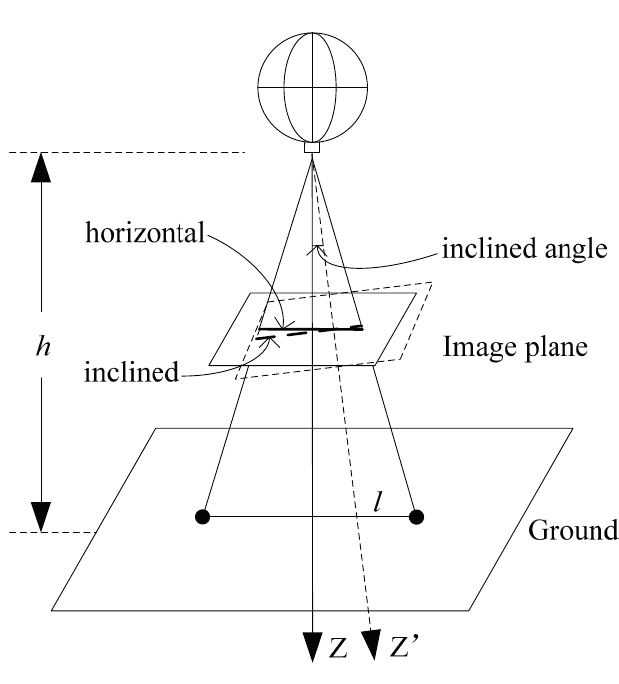
Figure 15. Inclined model of the